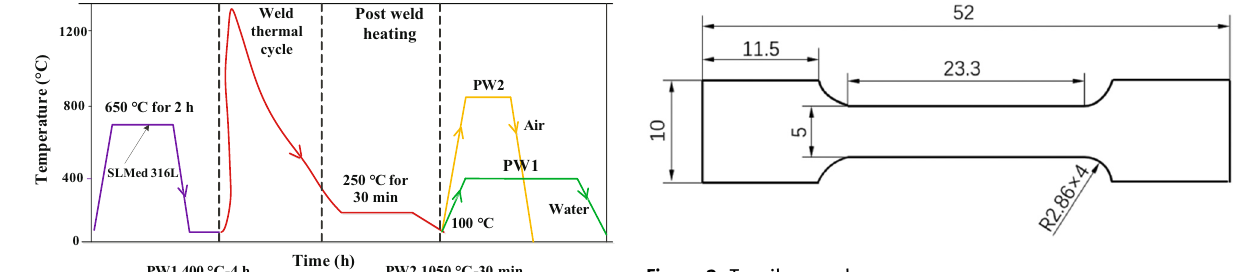
Figure 3: Tensile sample.